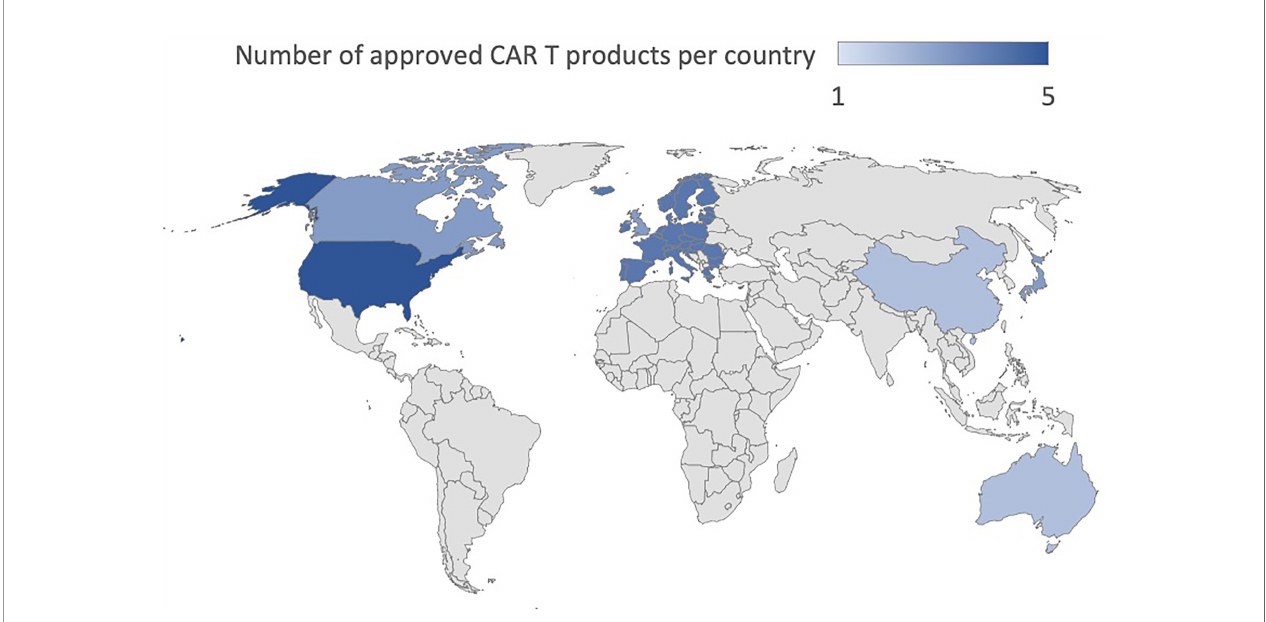
FIGURE 1 | Worldwide approval status of CAR T cell